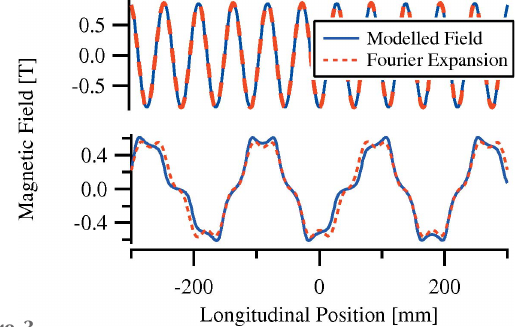
Figure 3 Magnetic field profile (solid) and effective field (dashed) calculated from